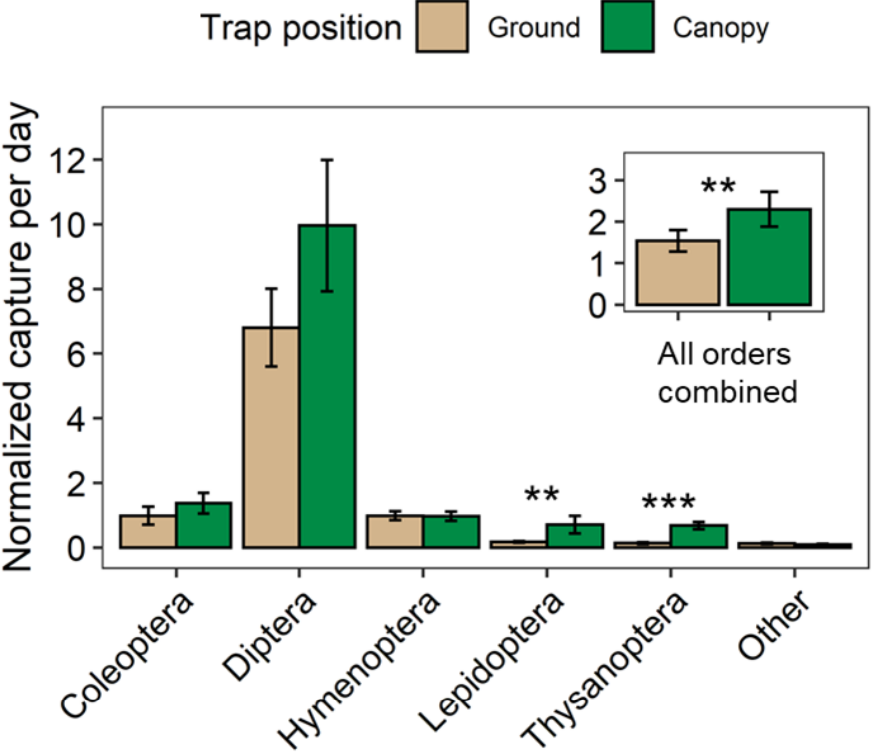
Figure 3. The abundance of insects captured in traps placed on the ground and in the canopy during the blooming period of black cherry. Asterisks indicate a significant effect of trap position on abun- dance of specific insect orders (**, p < 0.01; ***, p < 0.001).